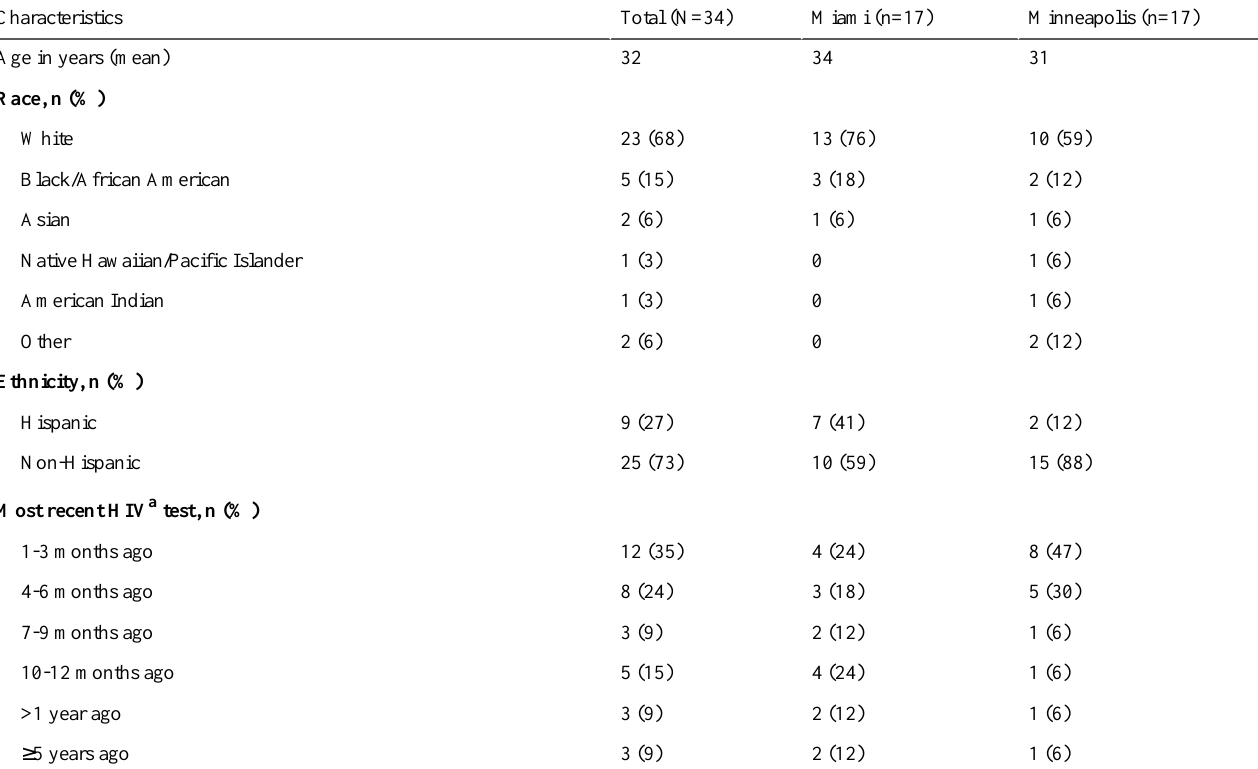
Table 1. Focus group sociodemographic